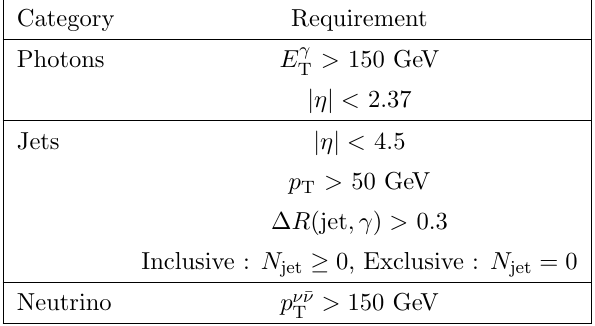
is the equivalent of E miss T T